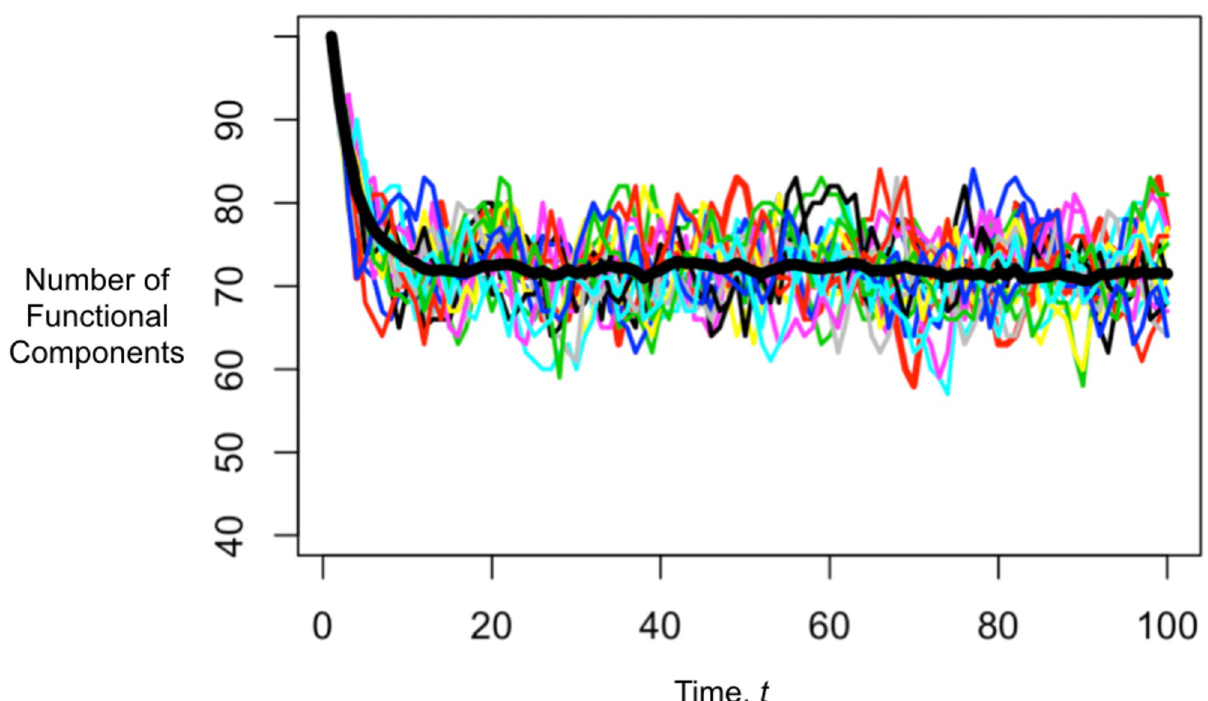
Fig 7. Fifty simulations of Eq 9 for N 0 = 100, p individual